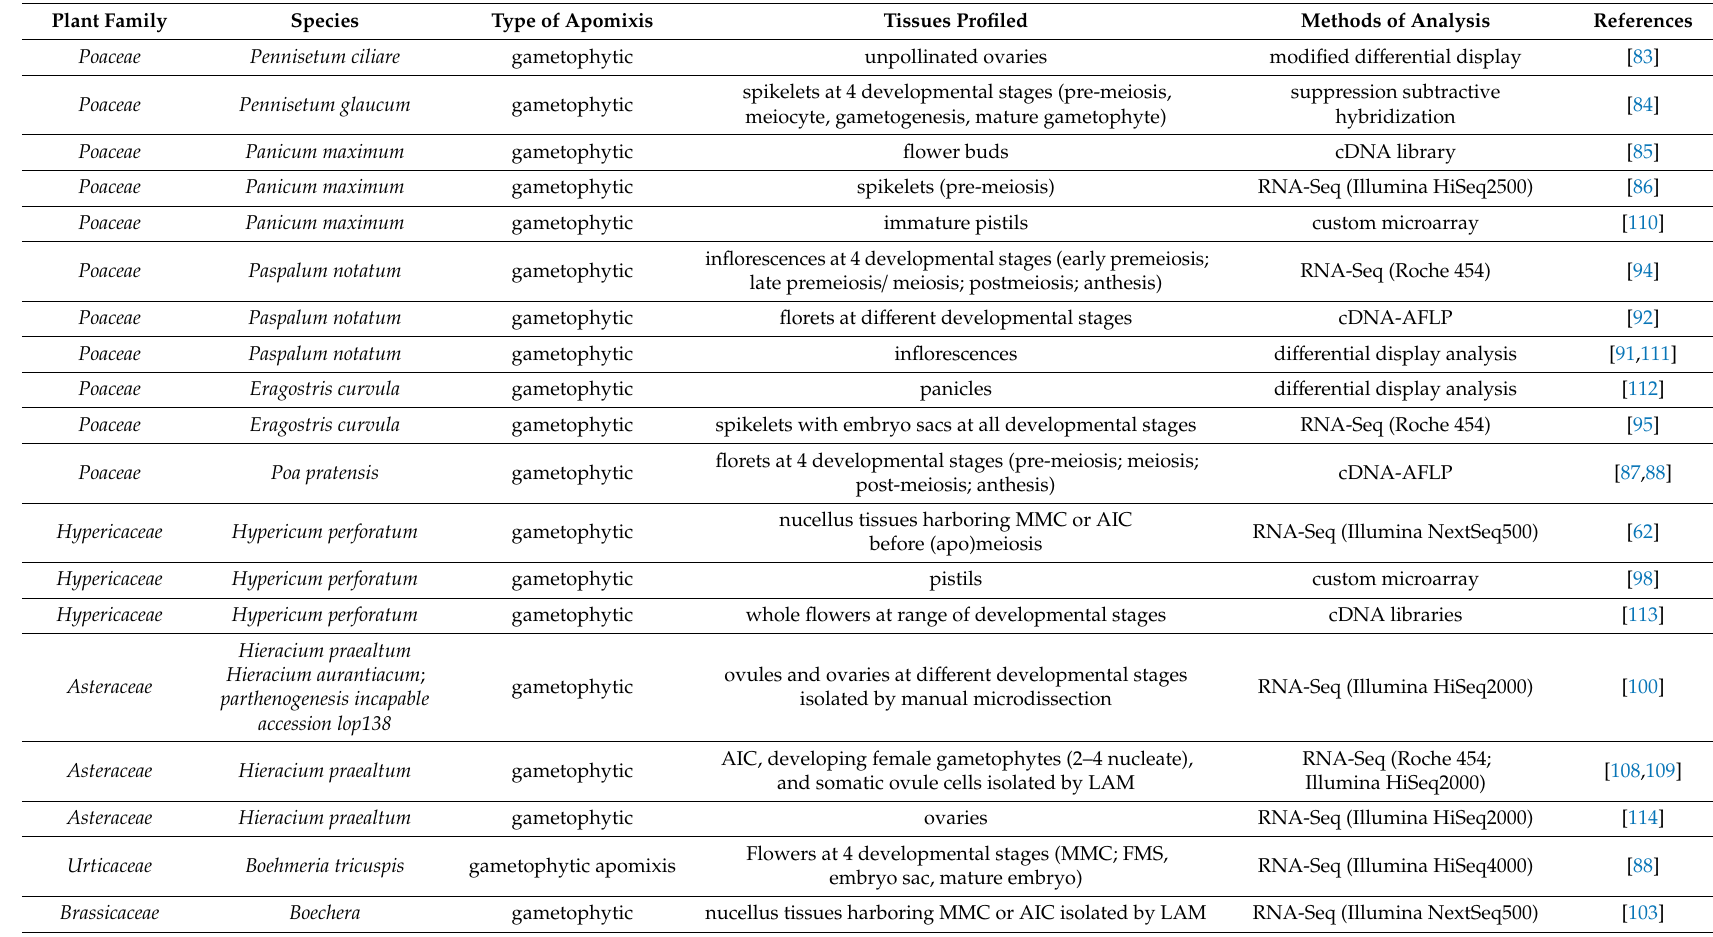
Table 2. Transcriptional analyses on reproductive tissues to identify genes involved in apomixis